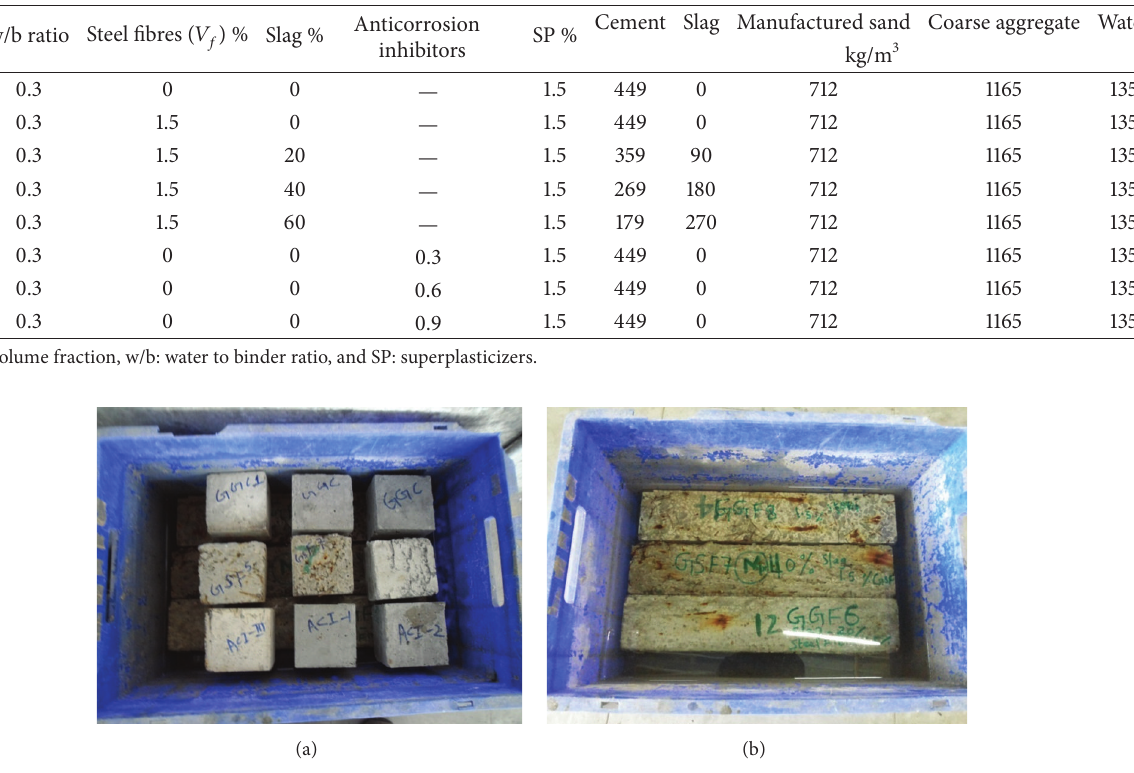
1.5% by weight of the binder. A horizontal pan mixer of 40 litres capacity was used for mixing the constituent